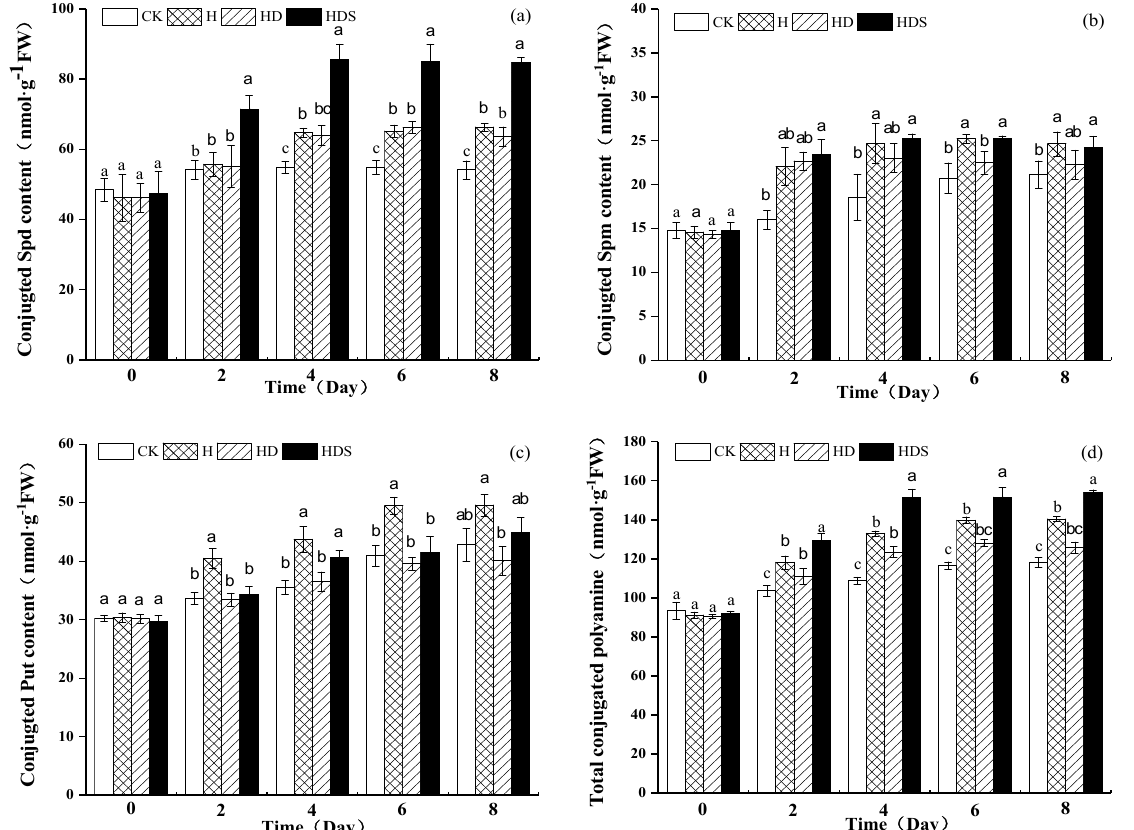
Figure 4. Effects of exogenous spermidine and D-arg on conjugated Spd ( a ), Spm ( b ), Put ( c ) and Total conjugated polyamines ( d ) content of lettuce under high-temperature stress. Vertical bars represent standard deviations of the mean ( n = 3). Values above each vertical bar followed by different letters show significant differences ( p < 0.05). CK, 22 ◦ C/17 ◦ C, deionized water; H, 35 ◦ C/30 ◦ C, deionized water; HD, 35 ◦ C/30 ◦ C, 1 mM D-arg; HDS, 1 mM D-arg+1 mM Spd. The bound Spd content of the H, HD, and HDS treatments (Figure 5a) was significantly higher than the bound Spd content of CK on day 2 of treatment, while the H and HD treatments were significantly higher than the bound Spd content of CK on days 4, 6, and 8 of treatment. There was no significant difference between these 2 treatments, while the HDS treatment increased the bound Spd content, and the difference was significant. The bound-state Spm content (Figure 5b) was higher in the H, HD, and HDS treatments than in CK on days 6 and 8 of the treatment, and the difference in bound-state Spm content was not significant among these three treatments. The bound state Put content (Figure 5c) was significantly lower on day 8 in the HD and HDS treatments than in the CK and H treatments. On days 4, 6, and 8 of treatment, the total bound state polyamine content was significantly higher in the H treatment than in CK (Figure 5d), and there was a